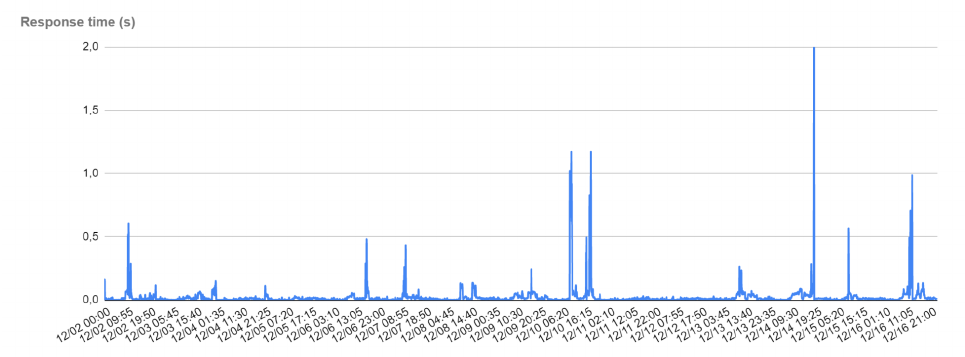
Figure 5. Average response time of the nodes (5 min